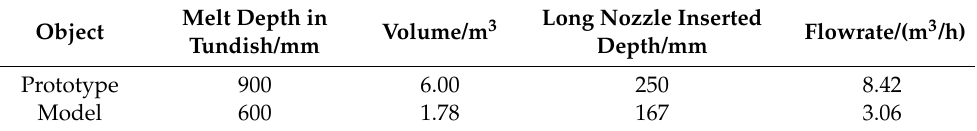
Table 1. Experimental parameters of the tundish prototype and water model.